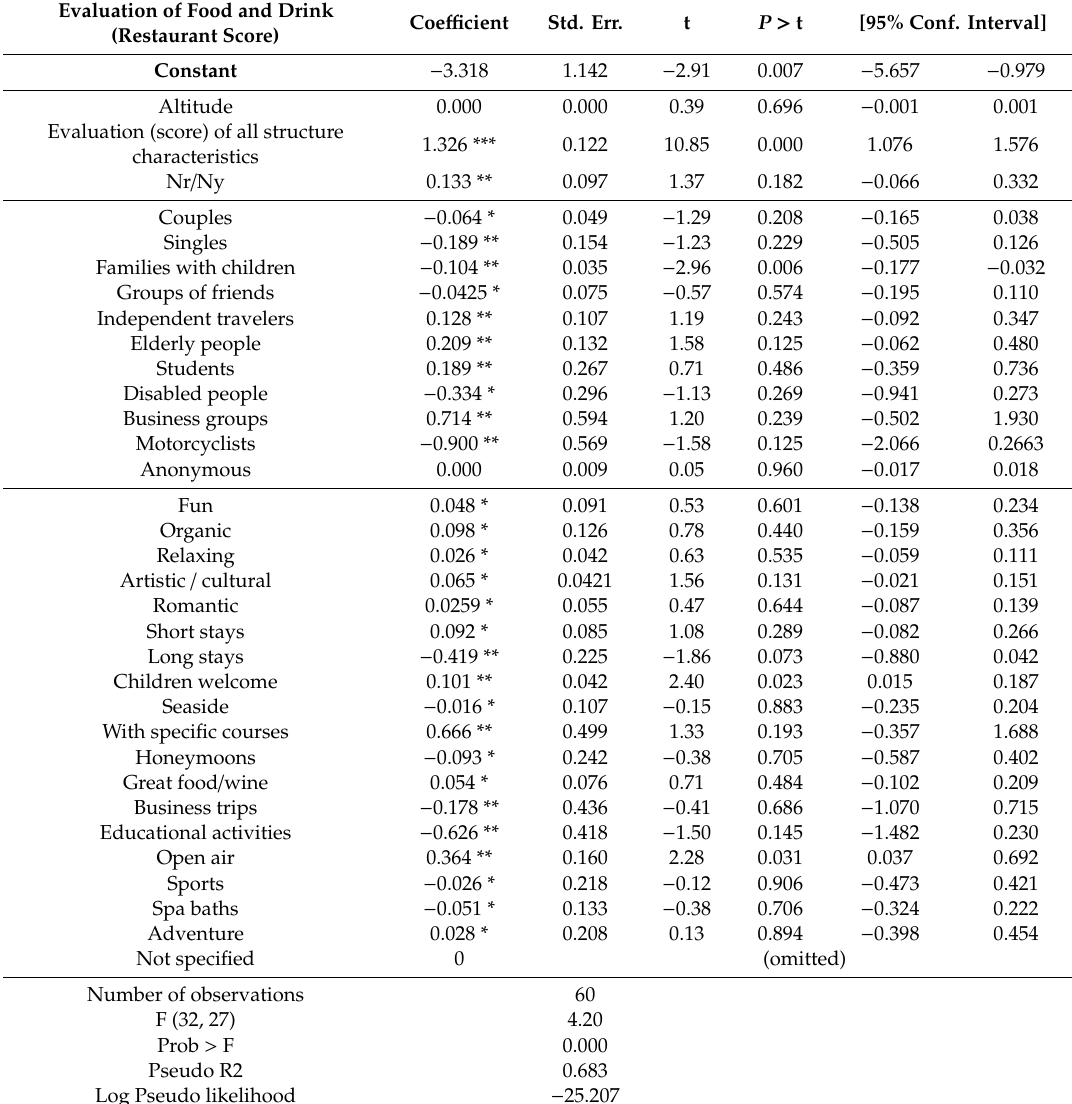
Table 2. Tobit regression estimates of determinates of the evaluation of restaurant